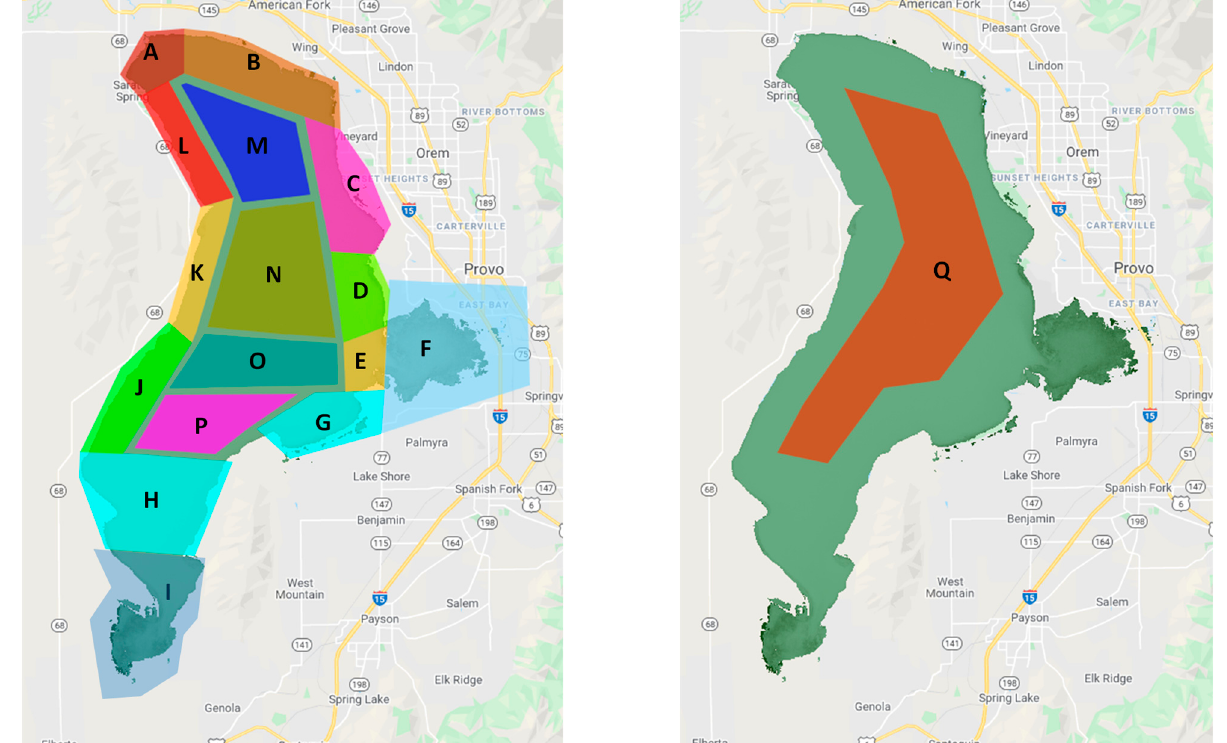
Figure 5. Utah Lake statistical analysis regions. The smaller regions are shown in the left panel (regions A through P) and a lake center region is shown in the right panel (region Q). We also computed statistics for the entire lake.